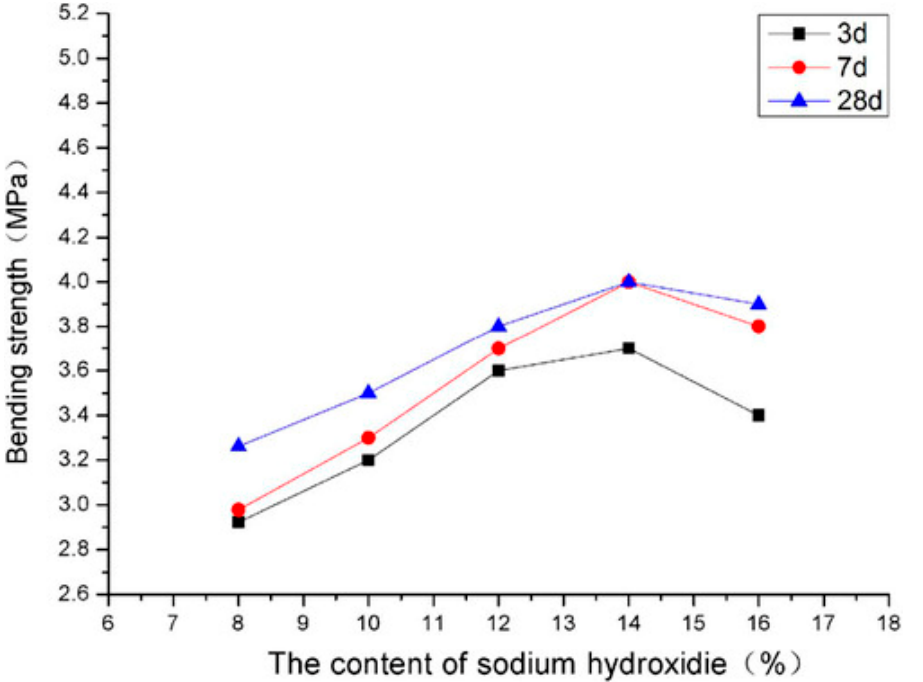
Figure 39. Effect of NaOH on bending strength [235]. Figure 39. E ff ect of NaOH on bending strength